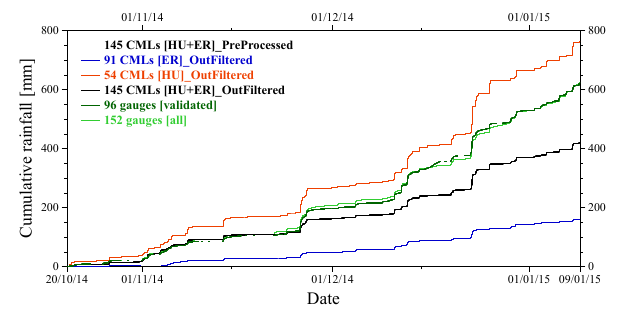
Figure 4. Cumulative time series of 30min rainfall averaged over the city of São Paulo, Brazil (see Fig. 1) for the period between 20 October 2014 to 9 January 2015. The dotted black line is for the “PreProcessed” RAINLINK approach, i.e. without wet–dry classi- fication and outlier filter, whereas the continuous black line is for the “OutFiltered” RAINLINK approach (with wet–dry classifica- tion and outlier filter). Both results (black lines) are obtained from the joint retrieval of Huawei and Ericsson CMLs ([HU + ER]). The blue line is for the ER CMLs only, whereas the orange line is for the HU CMLs. The dark green line is for the valid gauges only. A gauge is deemed valid if its coefficient of correlation ( r 2 ) is larger than 0 . 6 and its relative bias is within ± 25% for at least one of the two closest gauges to which it is compared (see Sect. 2.2). The light green line is for all gauges in the CEMADEN network (in the vicin- ity of São Paulo). In the legend, the numbers indicate the number of devices (gauges or CMLs) used in the average. The blank spaces in the cumulative series indicate that data were not available for that particular time interval. It was assumed that no rainfall occurred in such blank spaces; therefore, the curve resumes with its immediate previous